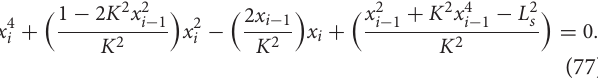
segments and 5 D-Bars are used to support and orient them. Each segment has a mass of m 100 kg and a length of L s 0.25 m . = = The initial length l 0 of all D-Bars are equal to 0.25m as shown in Figure 14 . The materials selected are as given in Table 1